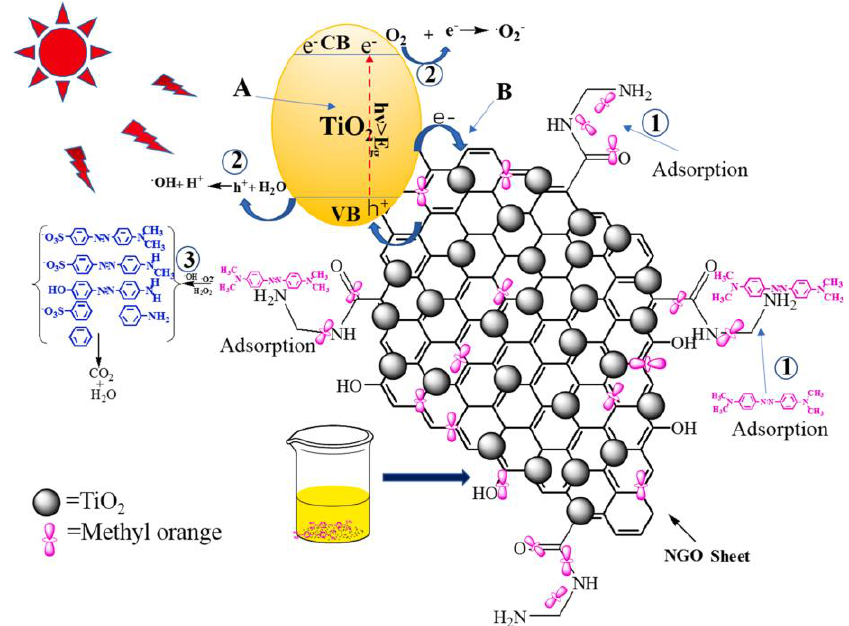
Figure 4. The photocatalytic process of nanostructured graphene-titanium dioxide. Reprinted with permission from Ref. [108].